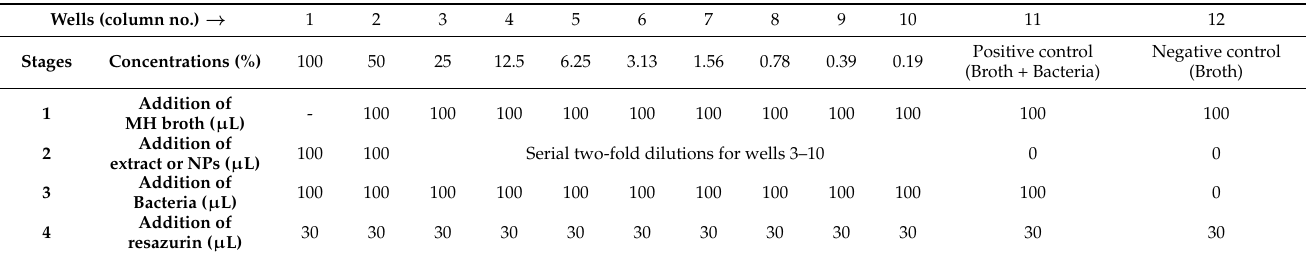
Table 2. Preparation steps of microtiter plate for the MIC